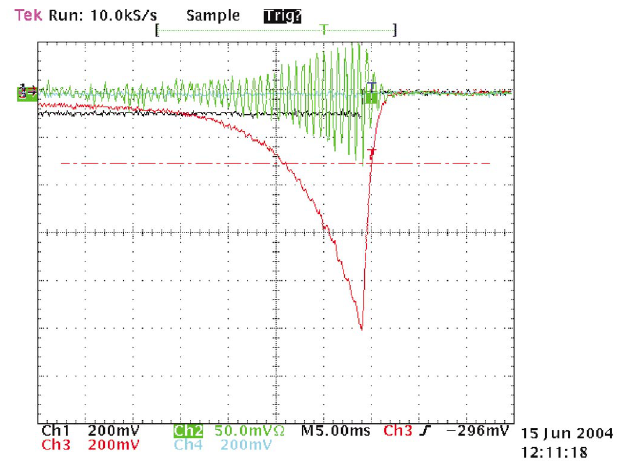
FIG. 2. (Color) Oscilloscope traces during a BBU induced ma- chine trip. The green trace is the cavity HOM voltage and the red trace is the total HOM power as measured from a Schottky diode. The time scale is 5 msec = div .